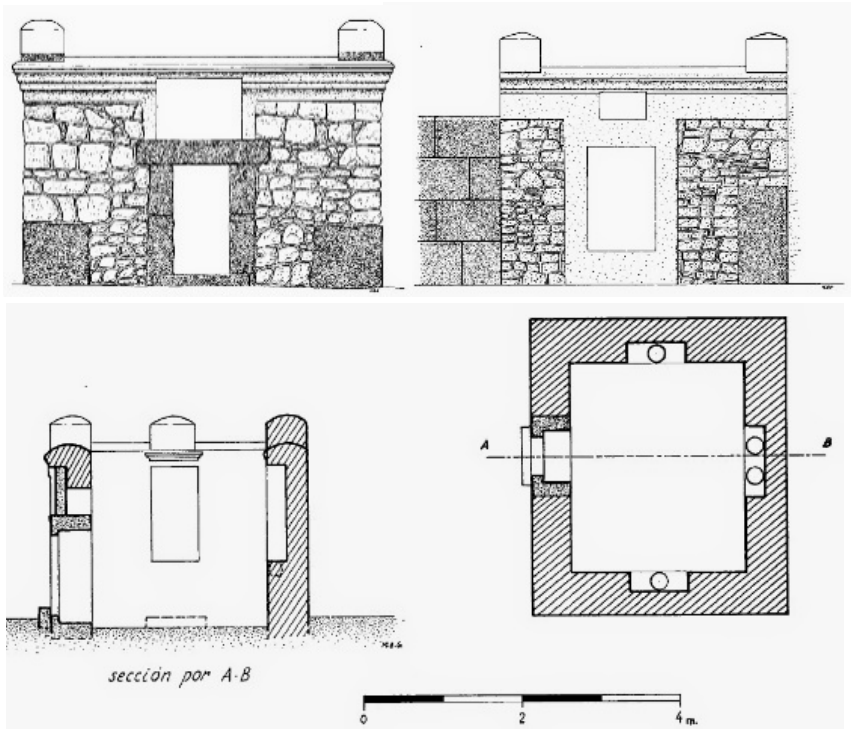
Figure 2. Existing planimetry published in the monograph Los Columbarios: arquitectura y paisaje funerario .